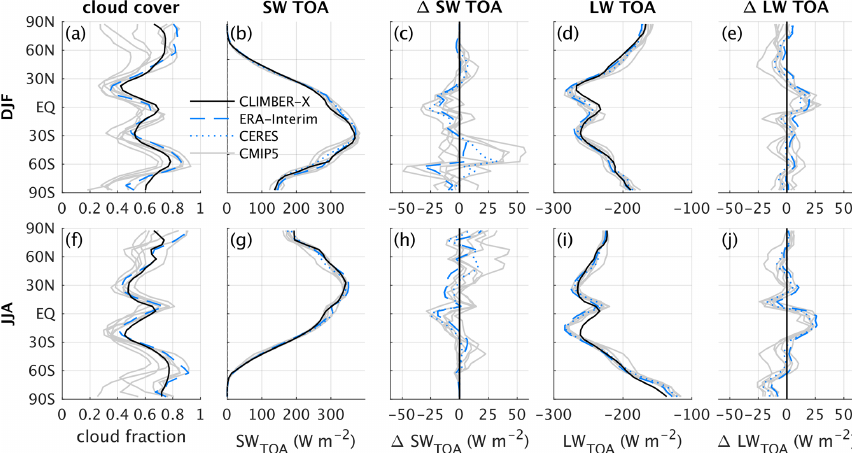
Figure 10. Simulated zonal mean cloud fraction and top-of-the-atmosphere net radiation fluxes for (top) DJF and (bottom) JJA compared to satellite observations (Loeb et al., 2018), reanalysis (Dee et al., 2011), and CMIP5